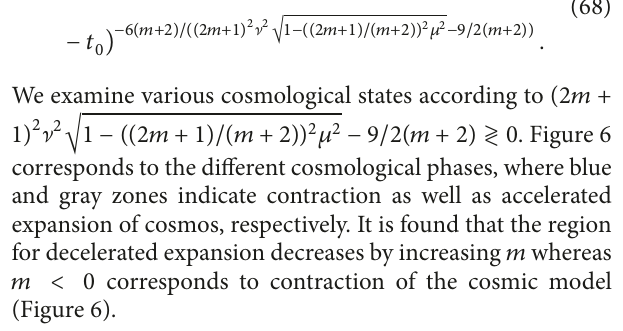
It shows exponential cosmic expansion for −9 + (2𝑚 + 1) 2 (𝜇 2 + ] 2 ) = 0 while −9 + (2𝑚 + 1) 2 (𝜇 2 + ] 2 ) ≷ 0 gives accelerated cosmic expansion or contraction,